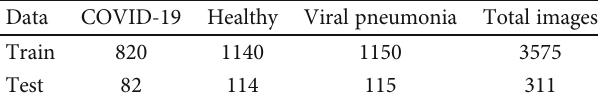
Table 1: Summarized dataset for training and